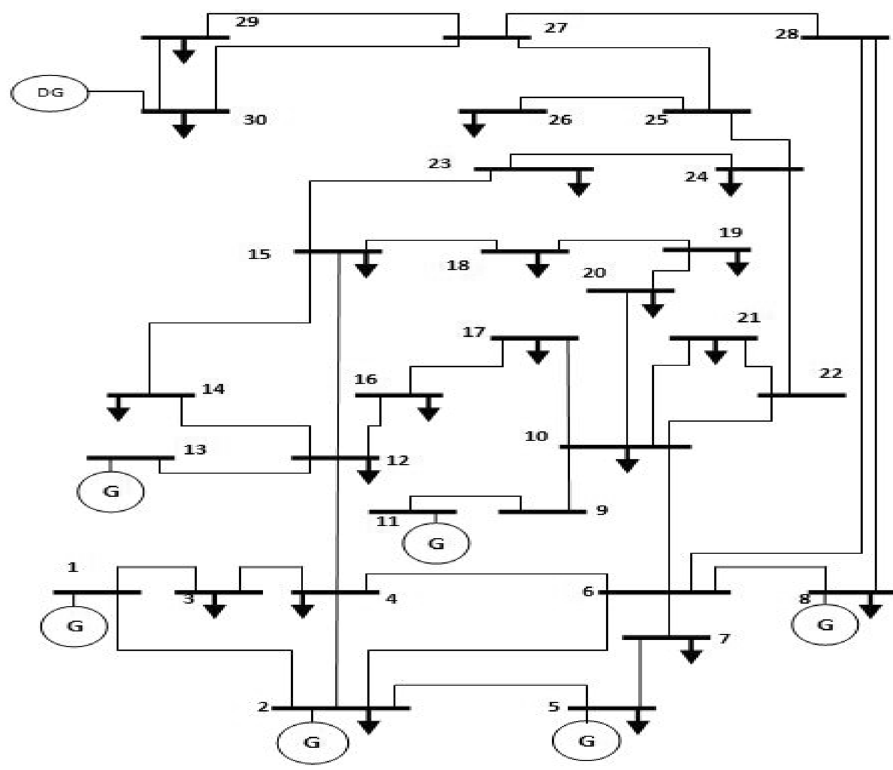
Table 1 Comparison of the radial networks obtained via manual switching and via application of Kruskal algorithm for a 3-node test system with and without DG integration DGDG status* Configuration